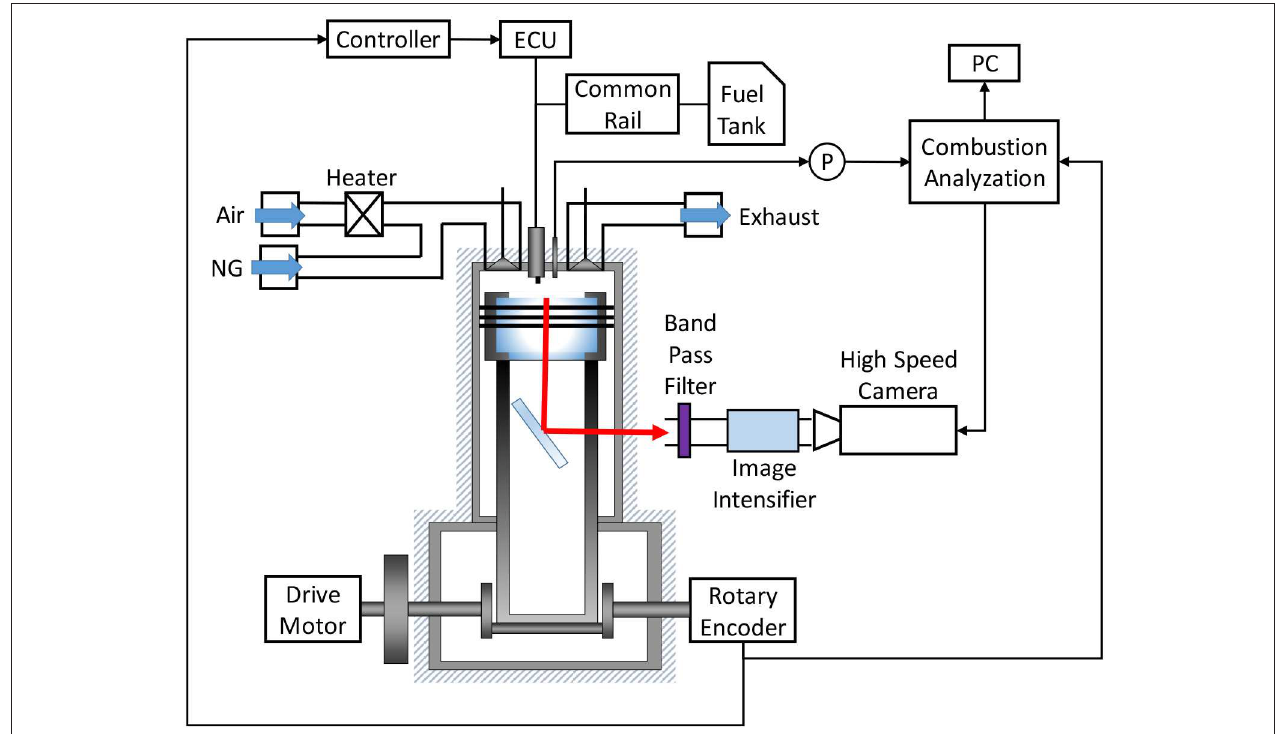
FIGURE 1 | Visualization engine setup.